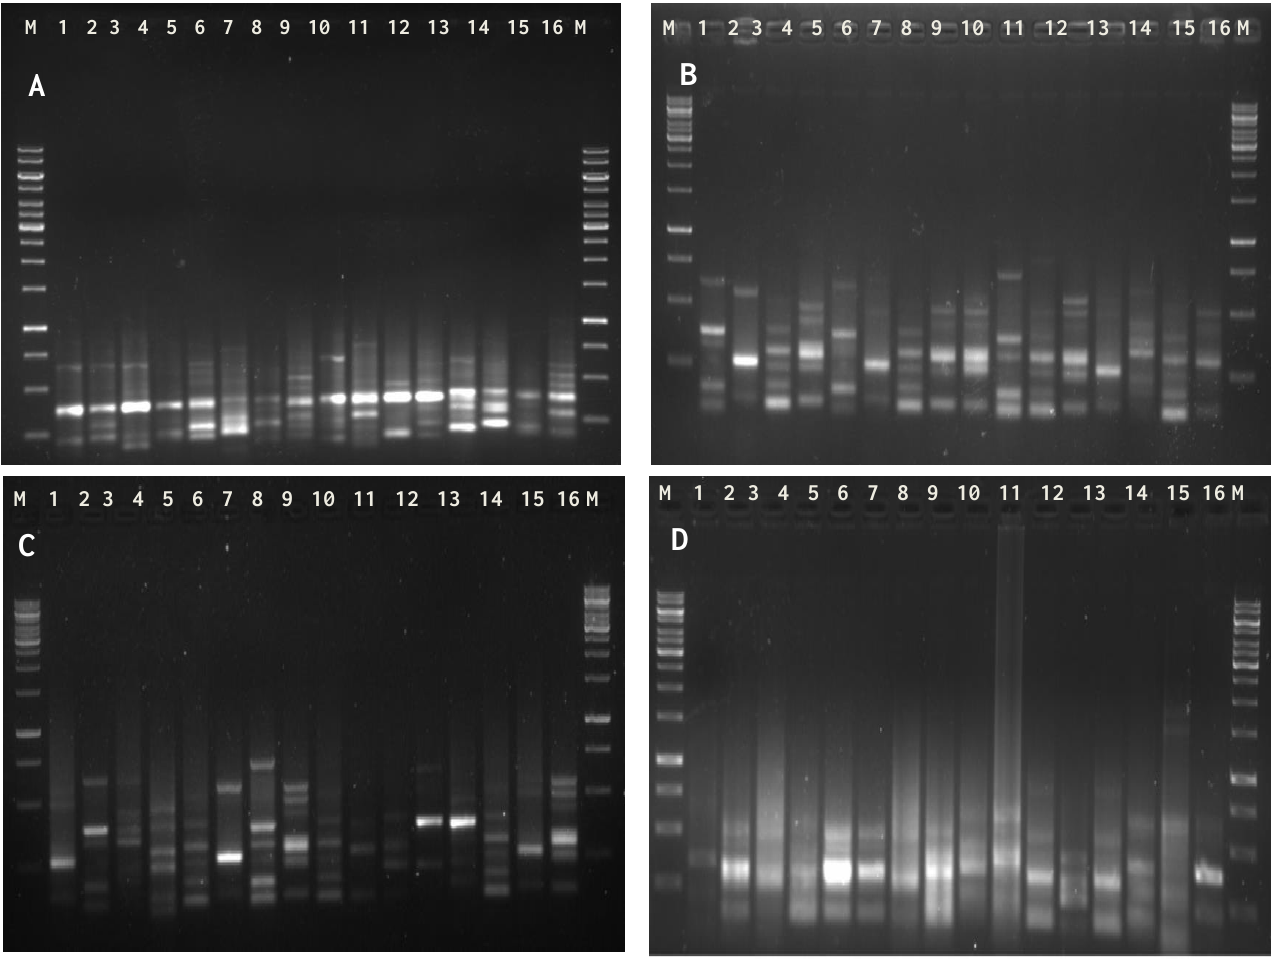
Figure 5. blkn - Tnt1 border amplification. (5A) Mfe I and EcoR I -double digestion the PCRII result using LTR4and EcoII oligonucleotide primers. (5B) Eco RI and Mfe I-double digestion PCRII result using LTR6 and EcOII oligonucleotide primers. (5C) Nde I and Ase I -double digestion test PCRII result using LTR4 and AseII oligonucleotide primers. (5D) Nde I and Ase I - double digestion PCRII test using LTR6 and AseII oligonucleotide primers. Lanes from 1-16 are, AG ,AT, AA, AC, CG, CT, CA, CC, GT, GG, GC, GA, TT, TG, TC, and TA separately at the end of oligonucleotide primers. AseII and